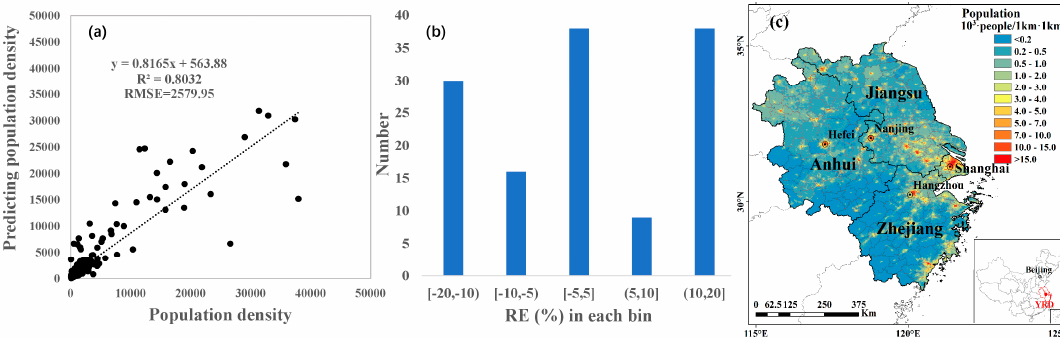
Figure 3. ( a ) 10-fold cross-validation (CV) for the random-forest (RF) model of population density estimation in 2013; ( b ) RE analysis of estimated population and census population in 2013; ( c ) spatial distribution of population at 1-km resolution estimated from the RF model in the Yangtze River Delta in 2013.